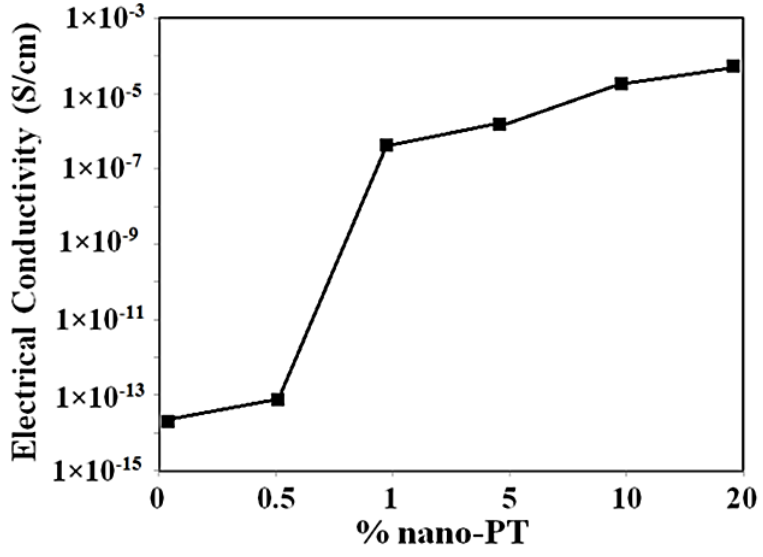
Figure 10. Electrical conductivity of epoxy/nano-polythiophene vs. % nano-polythiophene nanopar- ticle [126]. Reproduced with permission from Elsevier.